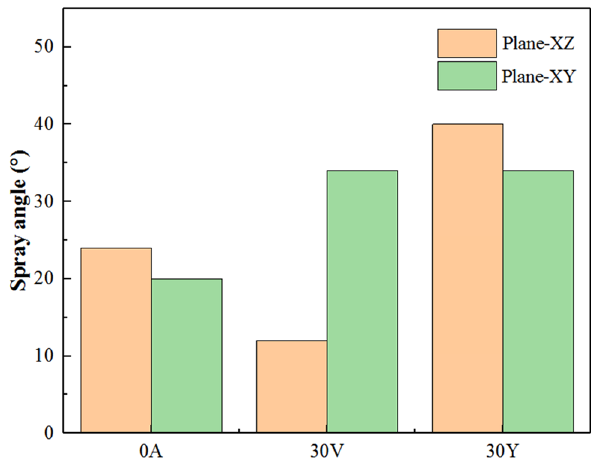
Figure 12: Spray angle of nozzles on the XY - plane and the XZ -